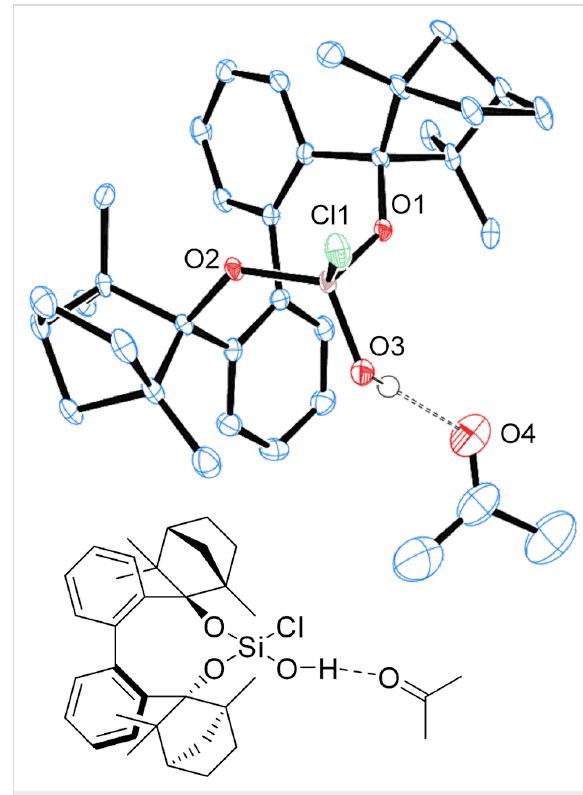
Counter ion catalyses The N -acyl Mannich reaction of isochinolin ( 16 ), which is acti- vated with 2,2,2-trichloroethoxycarbonyl chloride ( 17 , TrocCl) to carbamate 10 , and different silyl ketene acetals 11a –